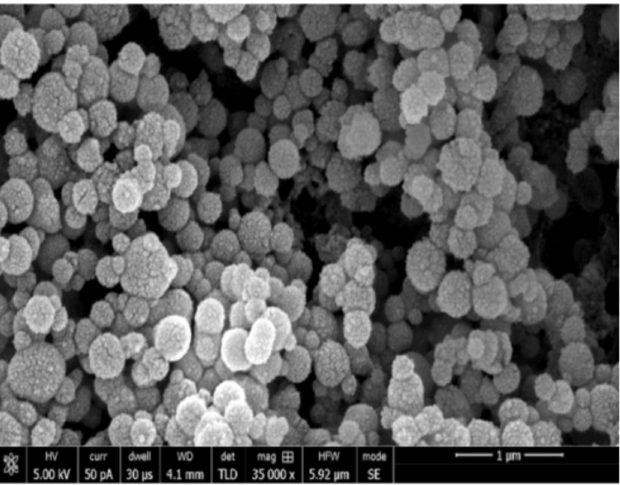
Figure 1. Presenting SiO 2 non-porous nanoparticles (150 nm) spherical in shape appear to be in agglomerated and isolated